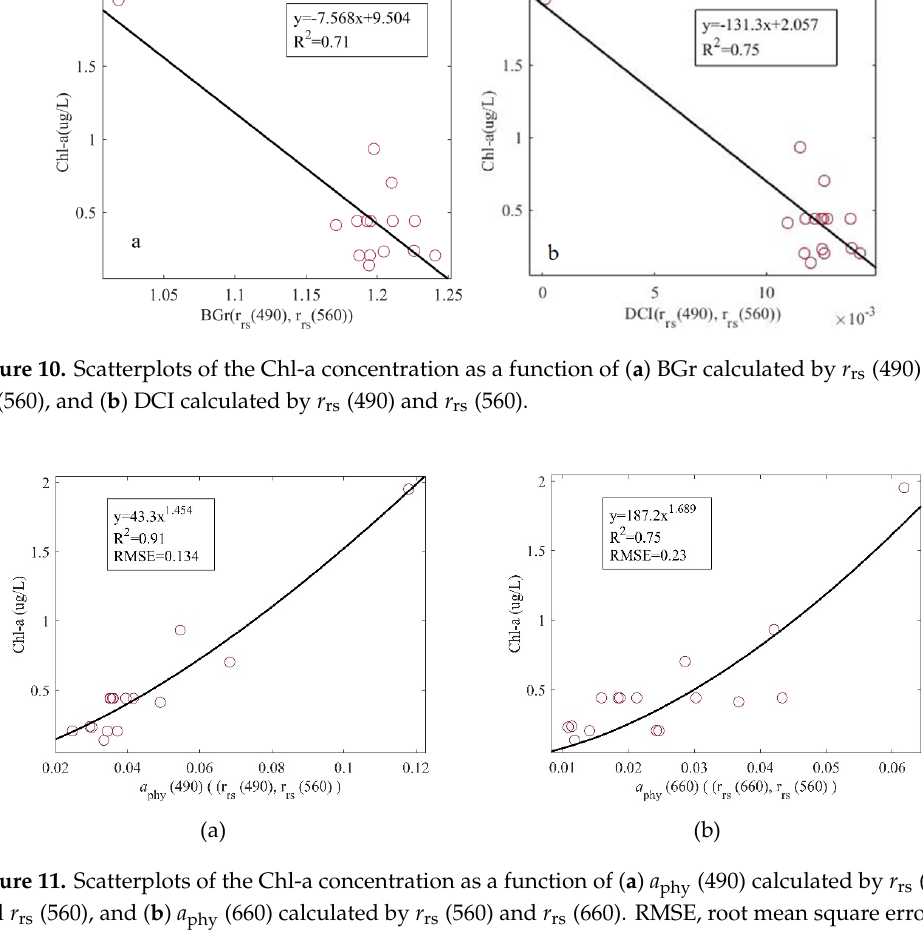
Figure 10. Scatterplots of the Chl-a concentration as a function of ( a ) BGr calculated by r rs (490) and r rs (560), and ( b ) DCI calculated by r rs (490) and r rs (560).